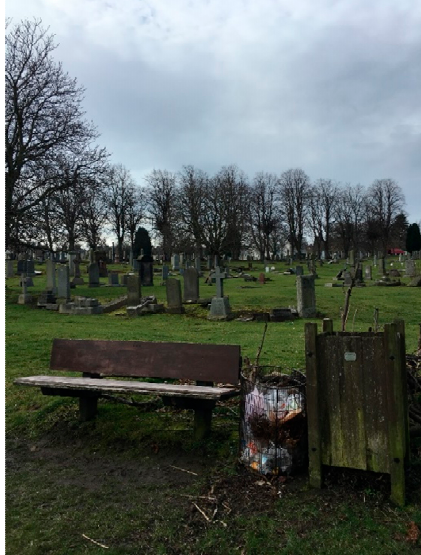
Figure 7. A wooden bench at the Morningside Cemetery.